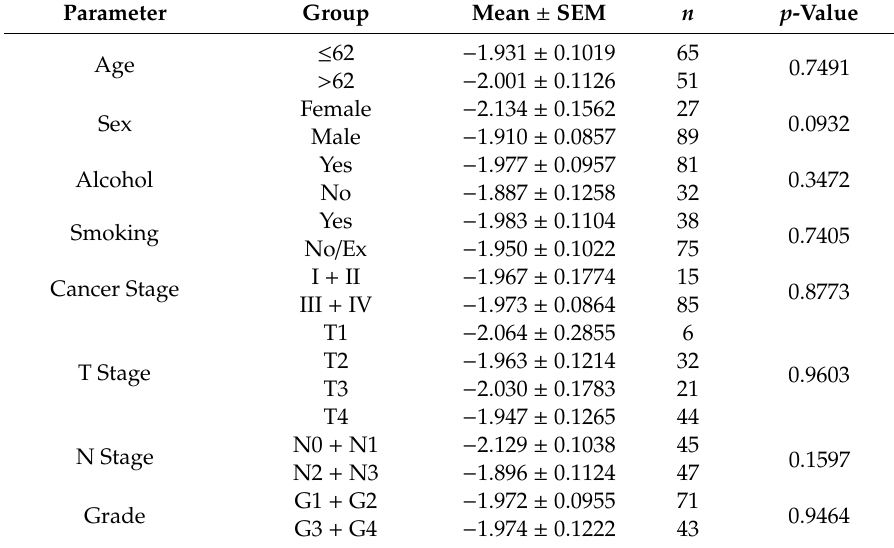
Figure 5. The expression levels of YRNA1 in three locations of HNSCC. Oral cavity ( n = 76), pharynx ( n = 19), and larynx ( n = 21); one-way ANOVA with Dunn’s multiple comparisons post-test; ns—not significant. Table 2. YRNA1 expression levels according to clinical-pathological parameters for all three HNSCC localizations from the TCGA data set; T-test; Mann–Whitney test; one-way ANOVA with Dunn’s multiple comparisons post-test; p < 0.05 considered as significant. Varying patient numbers reflect the availability of data. HPV, human papilloma virus.